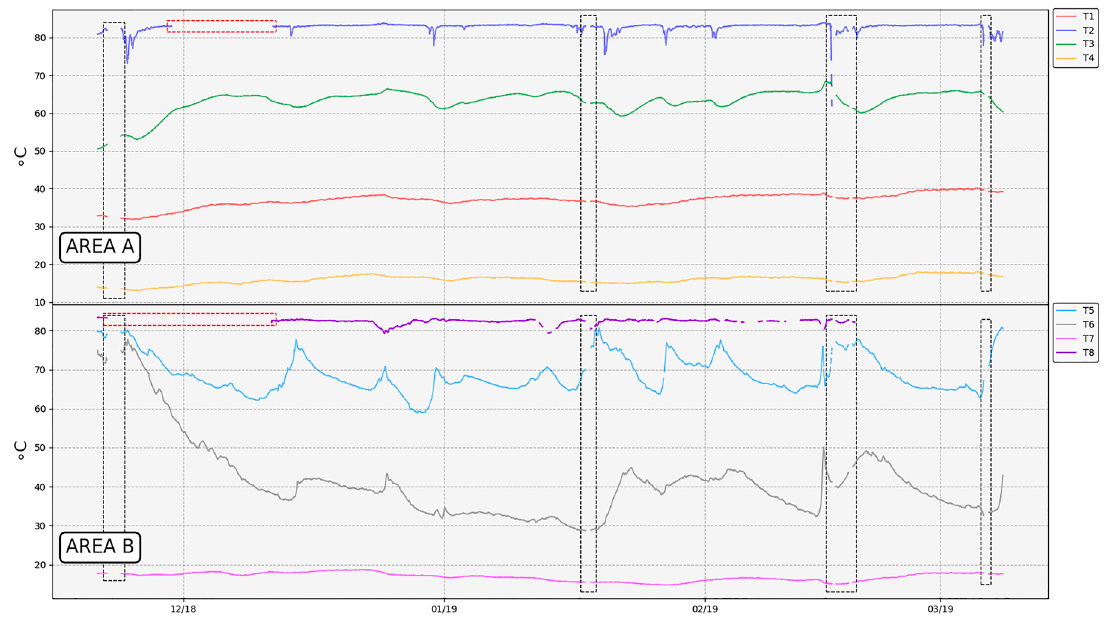
Figure 13. Temperature records. Grey dashed rectangles point out temporally interruptions in communications due to adverse weather conditions. Red dashed rectangles highlight malfunctions in thermometers T2 and T8.